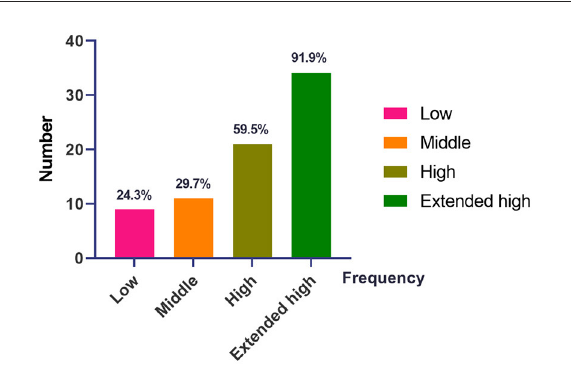
FIGURE1 The distribution of hearing loss at different frequencies in patients with pVM/VM. VM, vestibular migraine; pVM, probable vestibular migraine. Low, low frequency, 0.125–0.5kHz. Middle, middle frequency, 1.0–2.0kHz. High, high frequency,